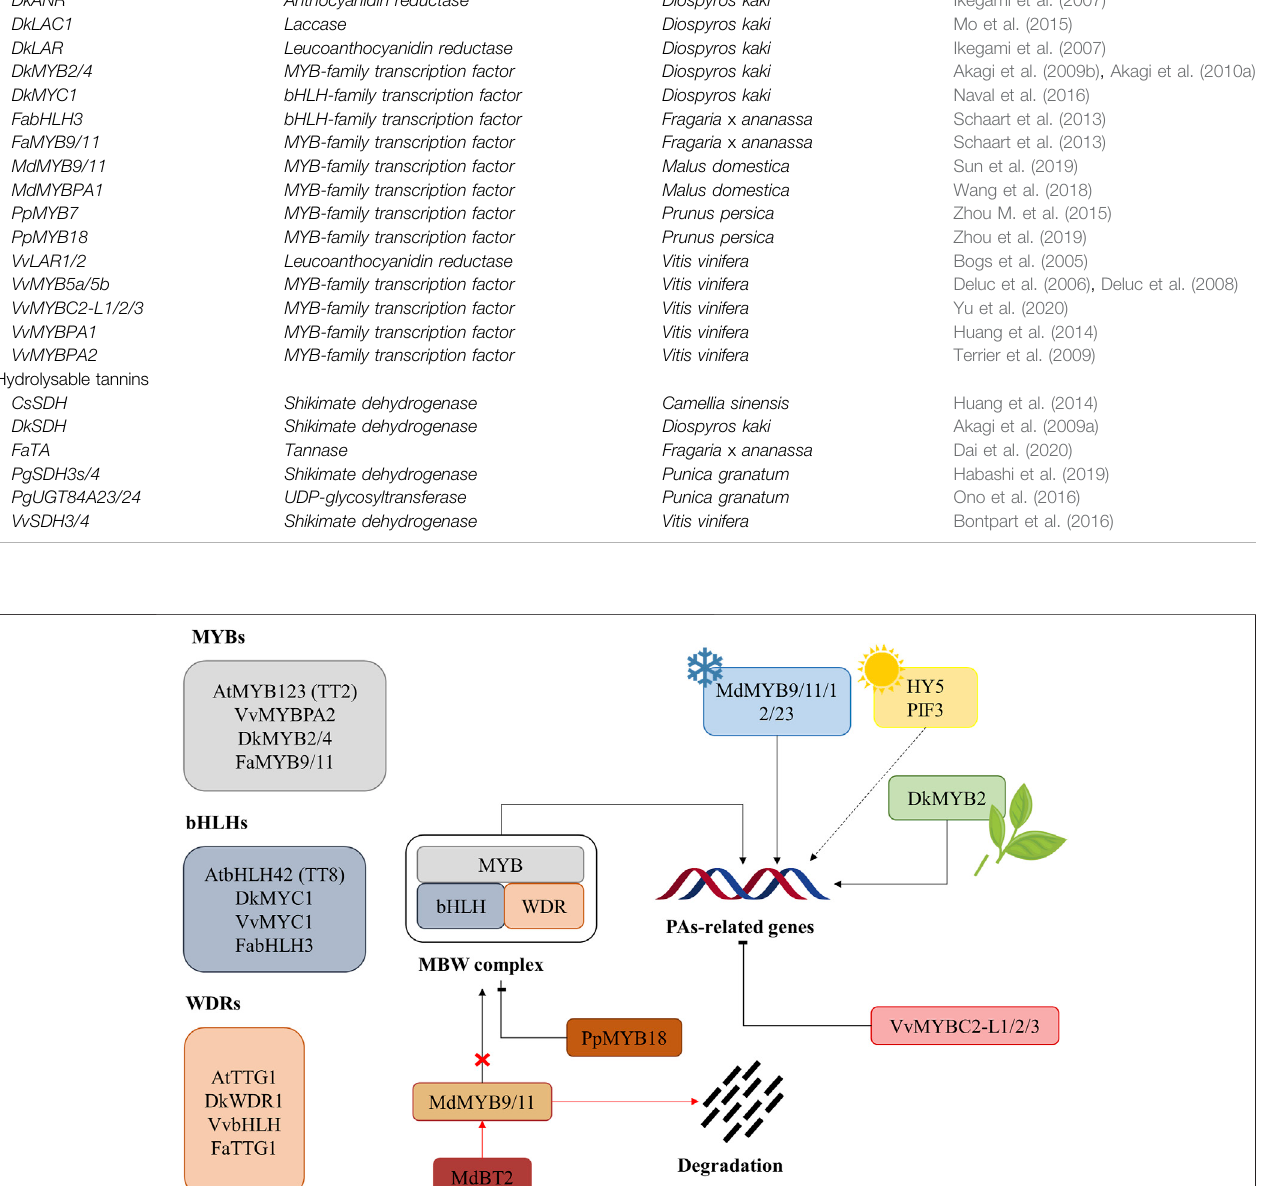
Frontiers in Genetics |